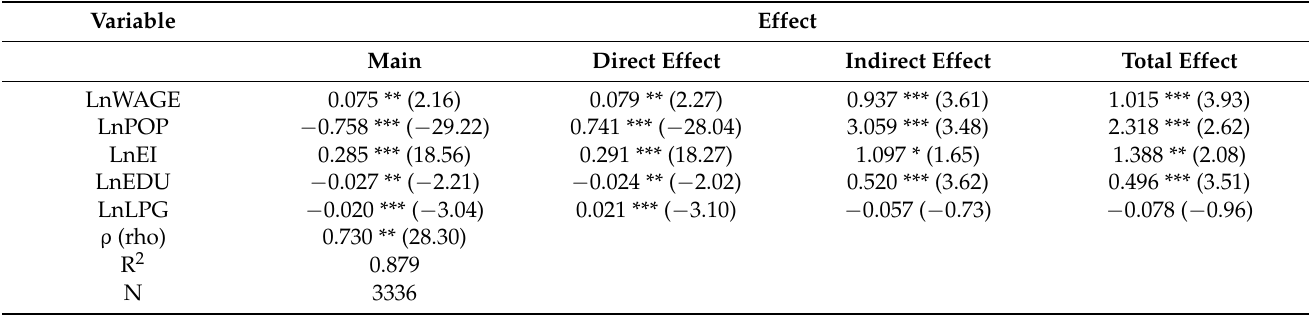
Table 8. Regression results of SDM under the economic distance spatial weight